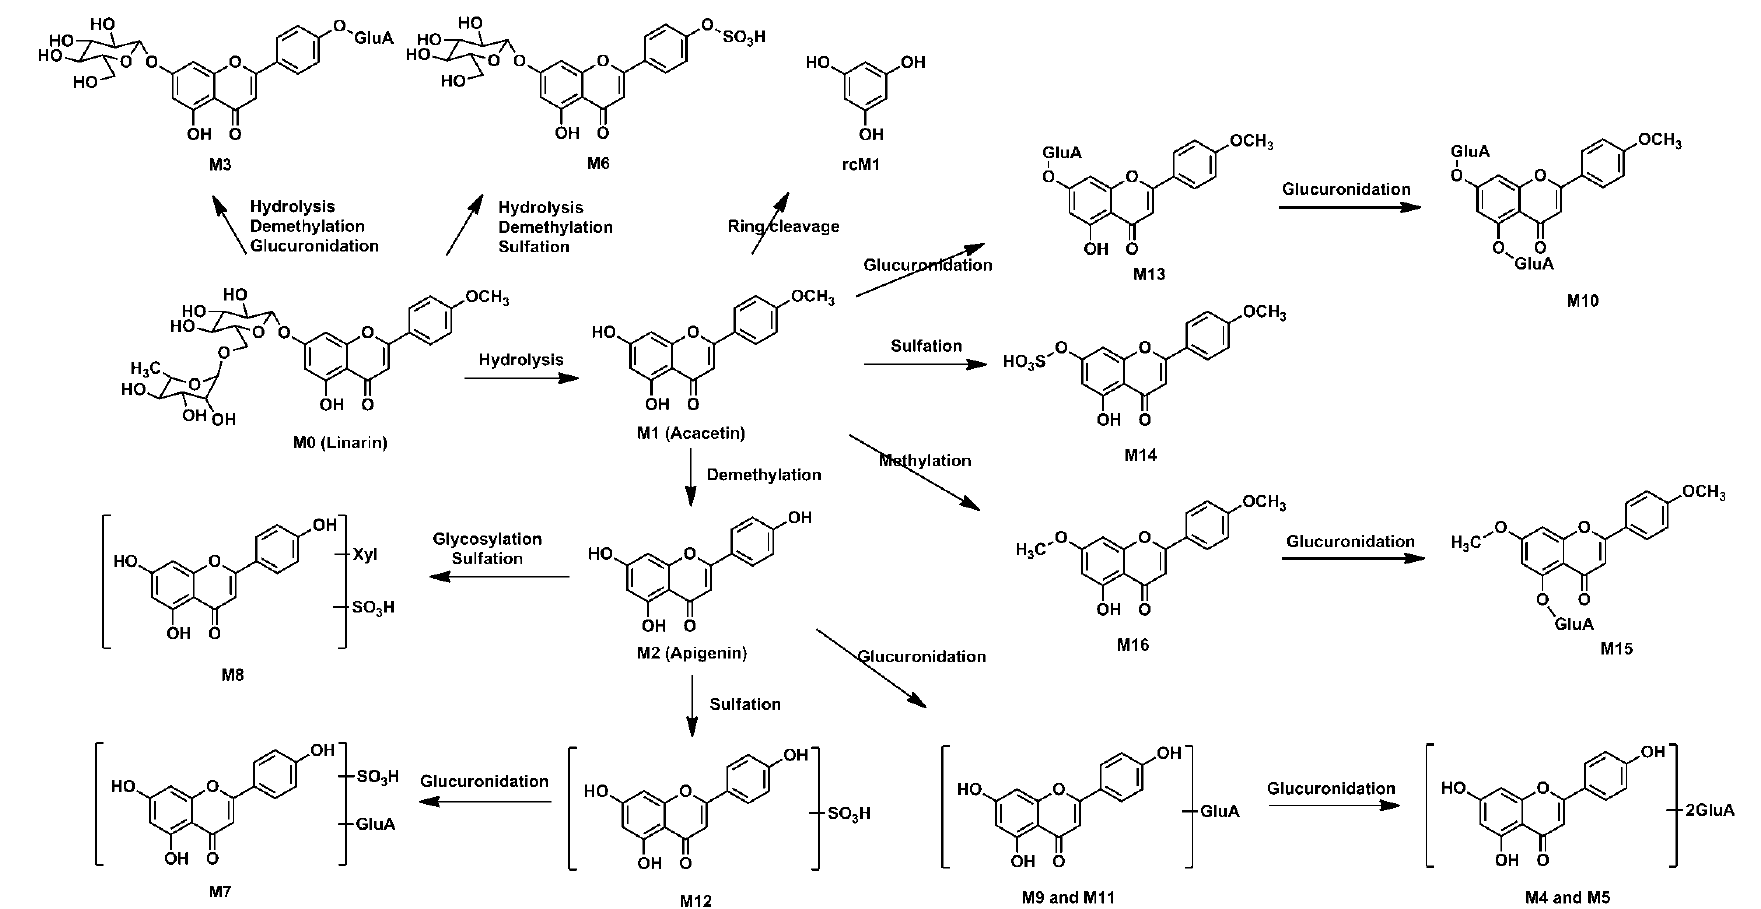
Figure 5. Proposed metabolic pathways of linarin in rats after oral administration. The position of glucuronidation and sulfation metabolism was speculated based on the reactivity of the free hydroxyl groups.